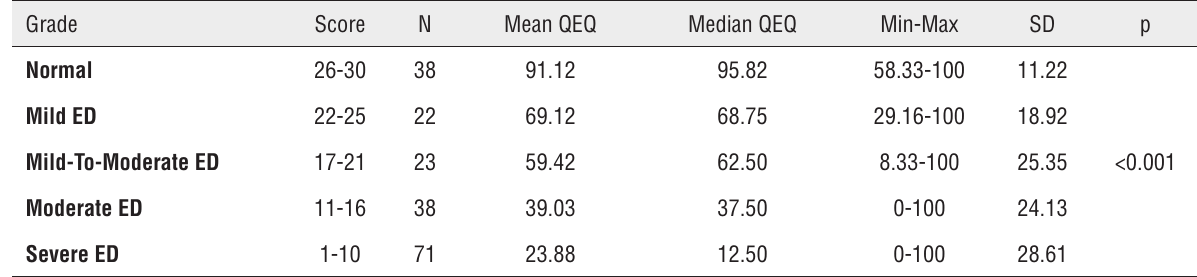
Table 5 - Correlation between Quality of Erections Questionnaires Score and Erectile Dysfunction (ED) degree.